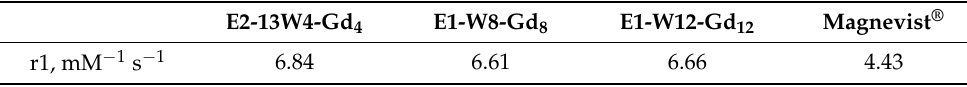
Table 7. Relaxivity values of protein-Gd complexes at pH